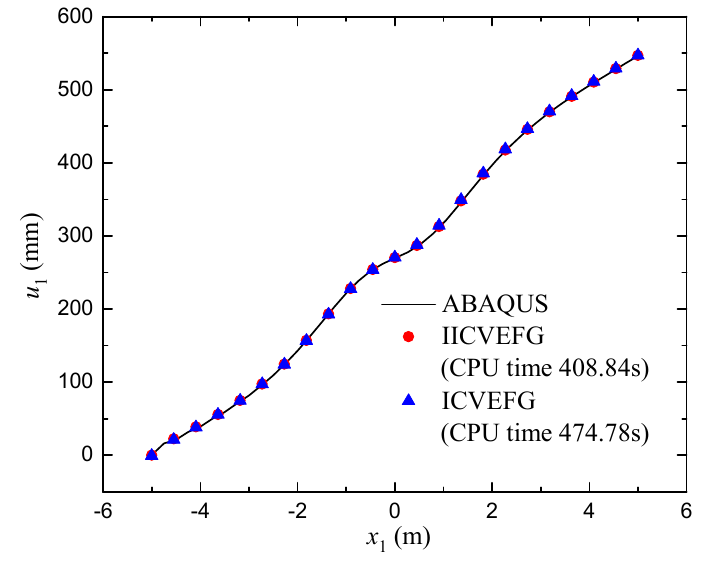
Figure 14. The displacement u 1 of the nodes on x 2 = − 2